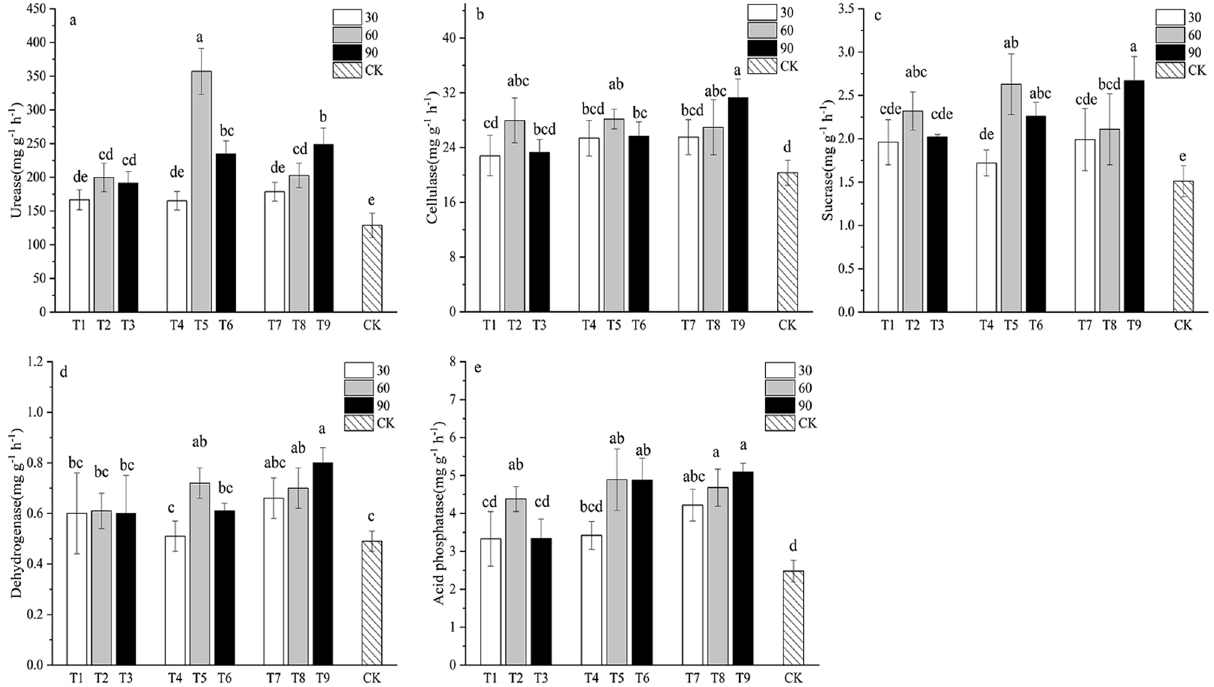
Figure 5. Soil enzyme activity at 90 days after inoculation of PSBs. ( a ) Soil total urease activity. ( b ) Soil cellulase activity. ( c ) Soil sucrase activity. ( d ) Soil dehydrogenase activity. ( e ) Soil acid phosphatase activity. Different lowercase letters represent significant differences at p < 0.05